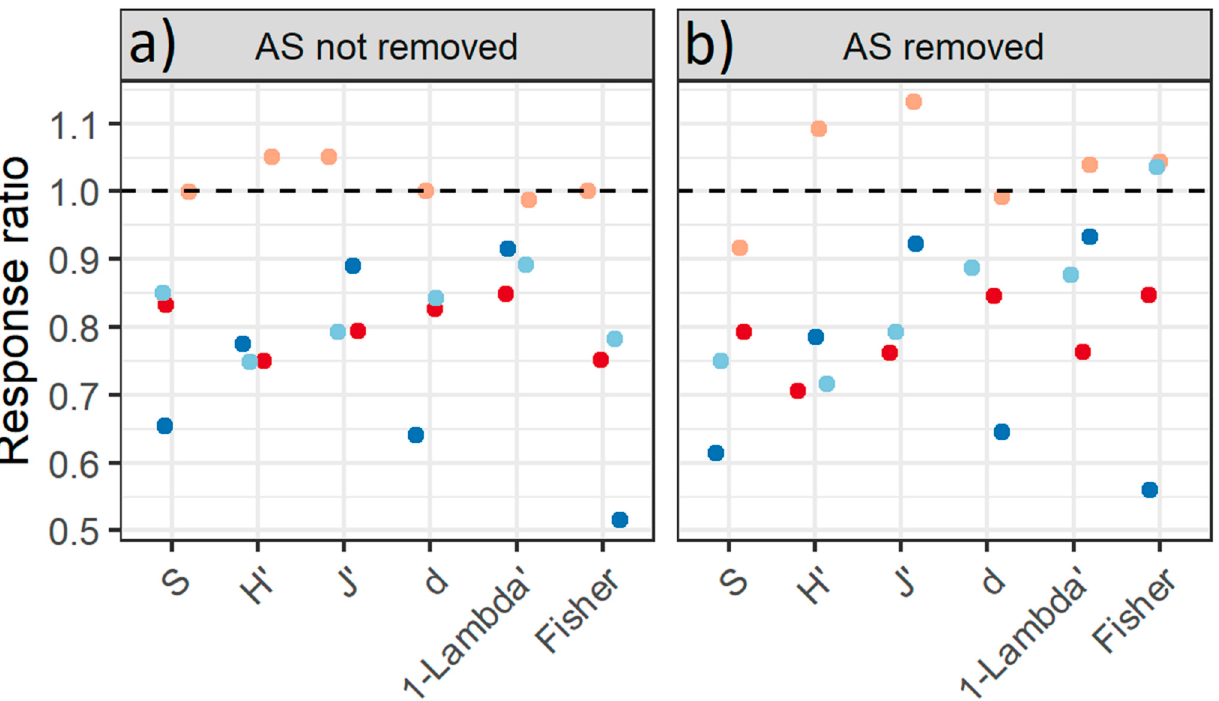
Figure 4. Response ratio between the taxonomy diversity indices (S, H ’, J’, d, 1-Lambda’ and Fisher) of the invaded communities (numerator) and not-invaded communities (denominator) under two scenarios: ( a )Alien species (AS) not removed and ( b ) AS removed on marine tropical rocky shores along the coast of the State of Rio de Janeiro, Brazil at Praia Vermelha (red), Praia da Baleia (orange); Ilha de Âncora (light blue) and Ilha Comprida (dark blue).